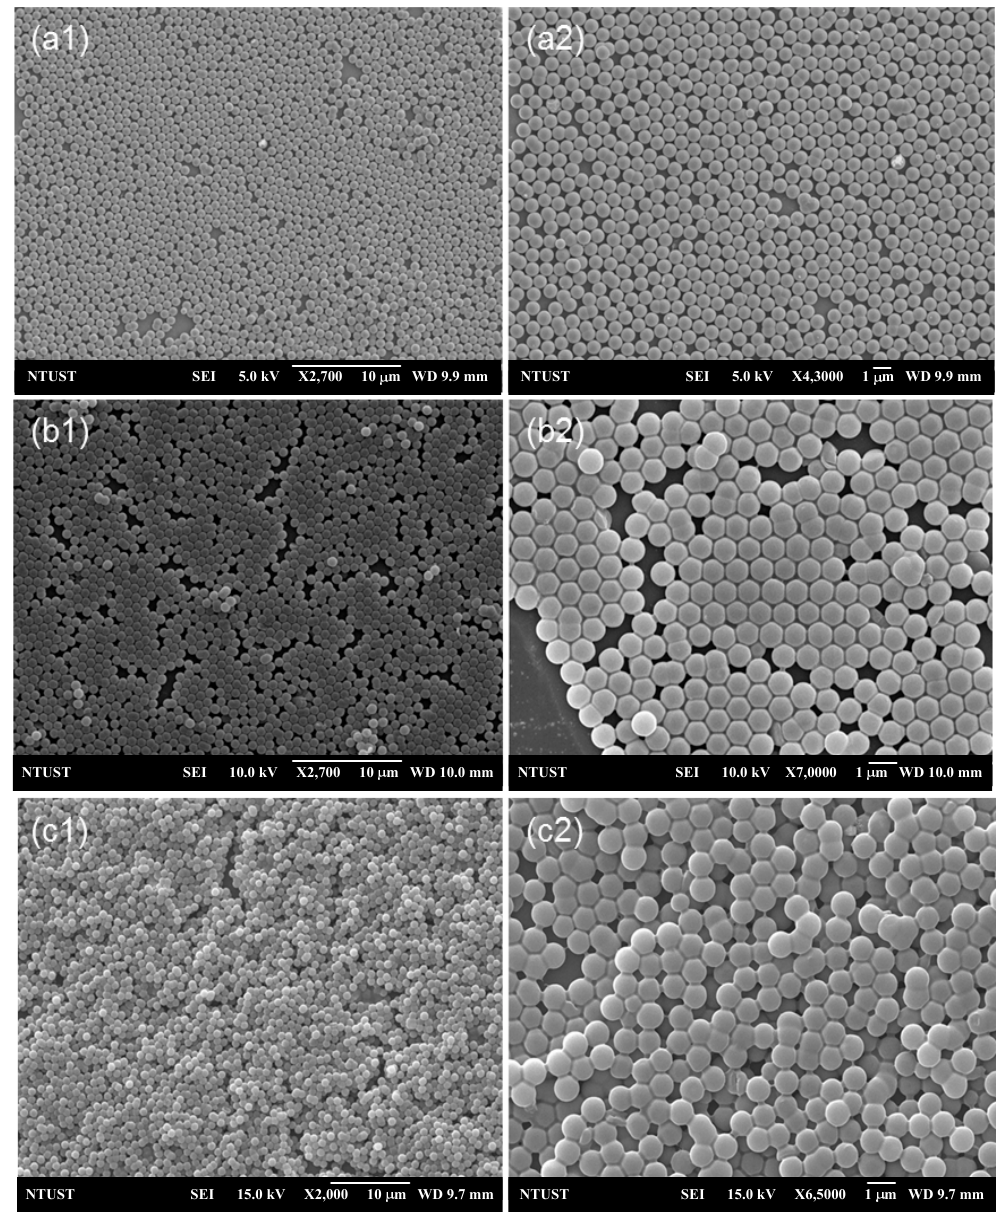
Figure 6. SEM images of the PCs of ( a ) bare silica microsphere array and SPMs array of ( b ) below and ( c ) above the LCST. ( c ) above the